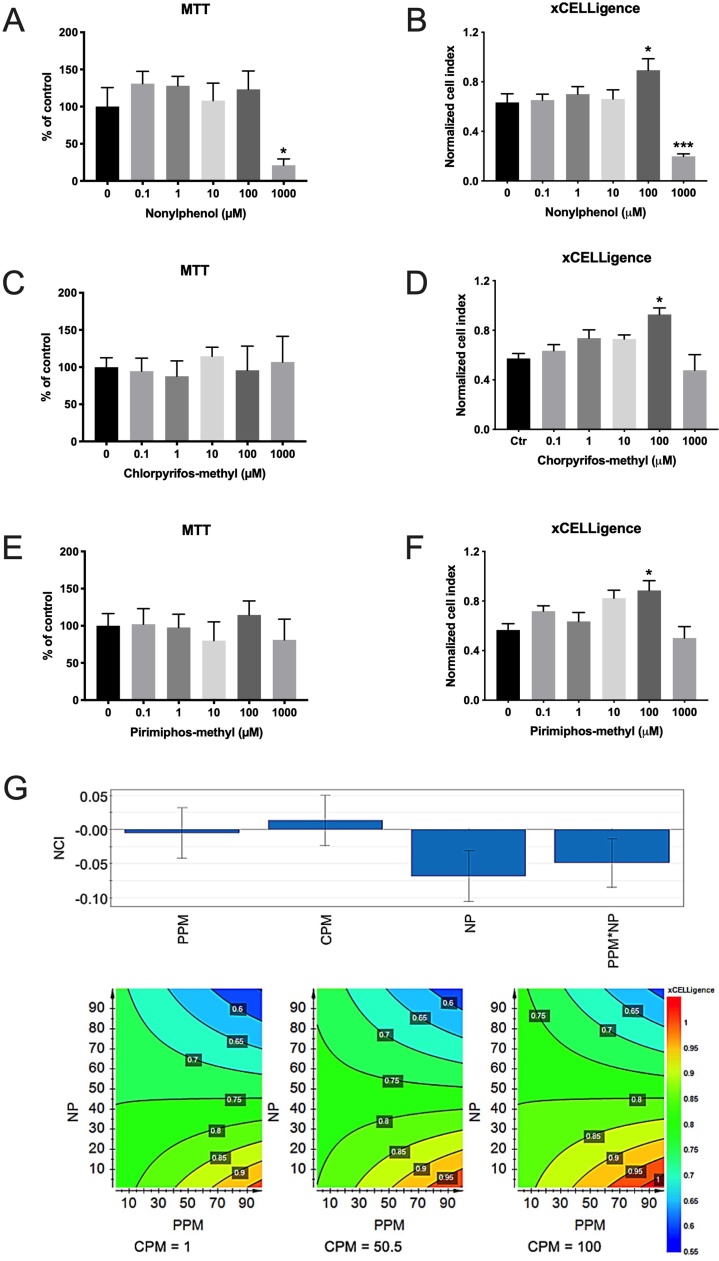
A-F) Dose-response-dependent cytotoxicity of chlorpyrifos-methyl (CPM), pirimiphos-methyl (PPM) and nonylphenol (NP) in Atlantic salmon hepatocytes determined with the MTT assay and the xCELLigence system. G) Simplified scaled and centered PLS regression coefficients with 95 % confidence intervals (upper figure) and contour plots (lower figure) based on normalized cell index (NCI) cytotoxicity (factorial design of xCELLigence data). The model contained one PLS component (R2 = 0.31 and Q2 = 0.10). The highlighted values in the contour plots represent NCI levels for the different stratification beddings (isoboles). The model was significant (regression: p = 0.001), with significant coefficients for NP (p = 0.0006) and PPM*NP (p = 0.0078) and showed a synergistic interaction between PPM and NP. Note, for the contour plots, blue color reflects the strongest effect with strongest reduction in NCI. (For interpretation of the references to colour in this figure legend, the reader is referred to the web version of this article).